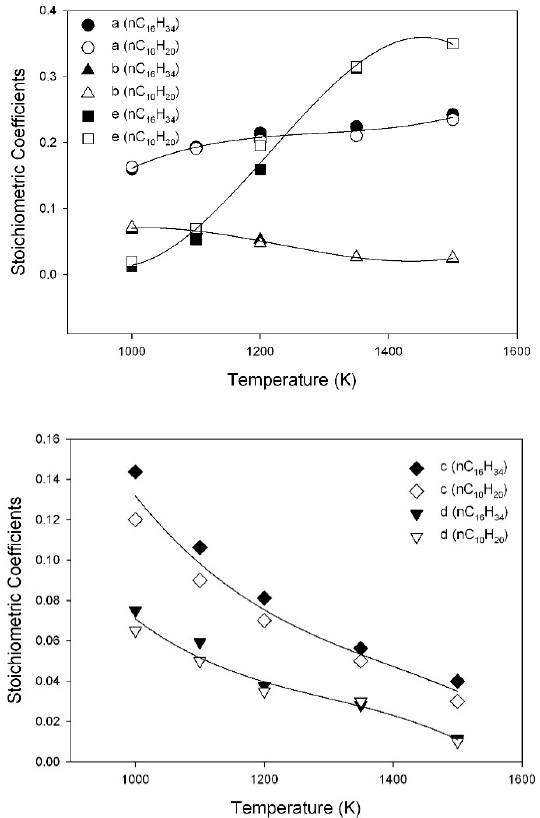
Figure 4. Stoichiometric coefficients for reaction 𝐶 (cid:3041) 𝐻 (cid:3040) → 𝑚𝑎𝐻 (cid:2870) + 𝑛𝑏𝐶 (cid:2869)(cid:2868) 𝐻 (cid:2876) + 𝑛𝑐𝐶𝐻 (cid:2872) + 𝑛𝑑𝐶 (cid:2870) 𝐻 (cid:2872) + 𝑛𝑒𝐶 (cid:2870) 𝐻 (cid:2870) for Figure4. Stoichiometriccoe ffi cientsforreaction C n H m → maH 2 + nbC 10 H 8 + ncCH 4 + ndC 2 H 4 + neC 2 H 2 for C n H m = nC 16 H 34 and nC 10 H 20 C n H m = nC 16 H 34 and nC 10 H 20